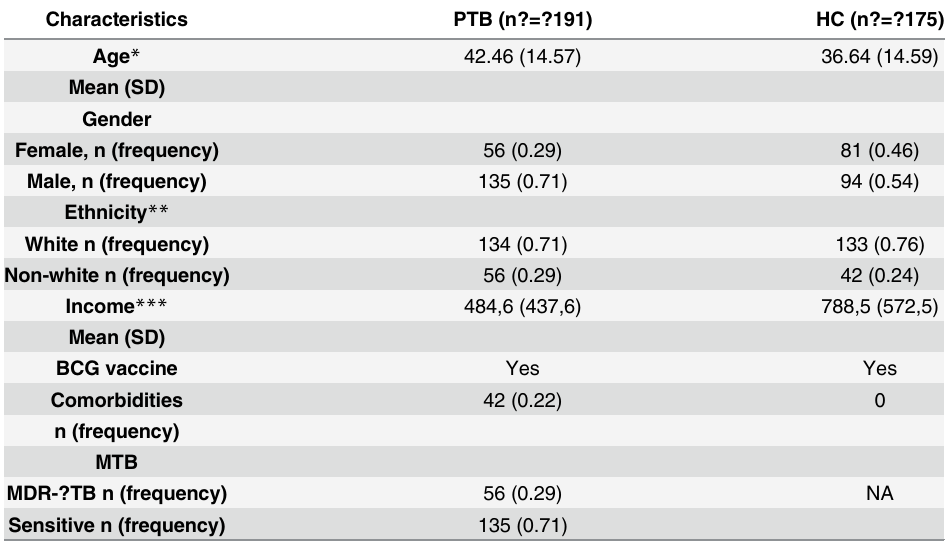
PTB pulmonary tuberculosis, HC healthy controls, n number of individuals, SD standard deviation, NA